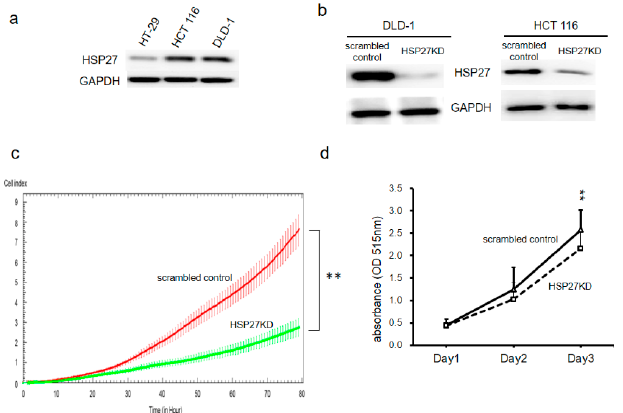
Figure 2. Targeting HSP27 reduced the cell proliferation activity. ( a ) HSP27 expression levels in CRC